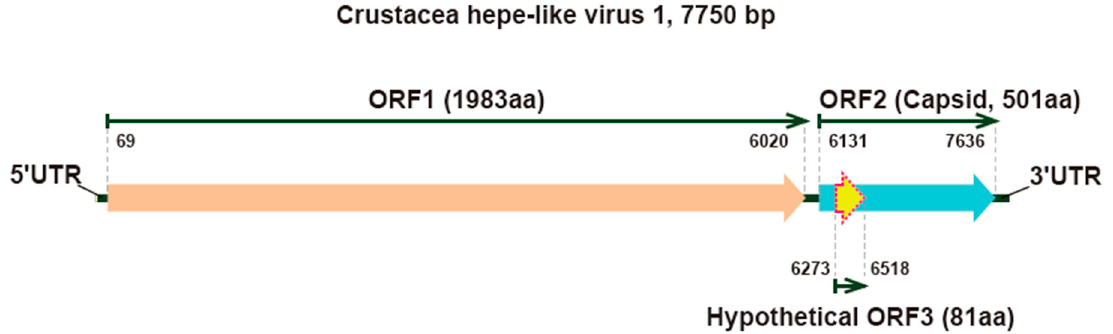
Figure 1. The predicted genome structure of the novel Crustacea hepe-like virus 1.